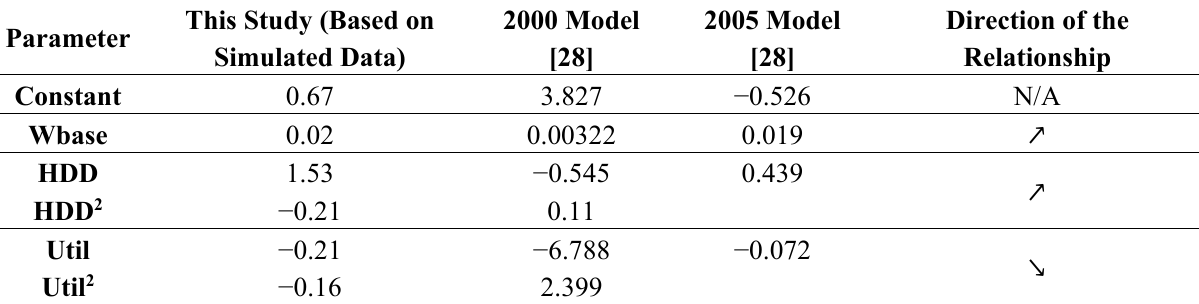
Table B2. Comparison of fuel SFA model